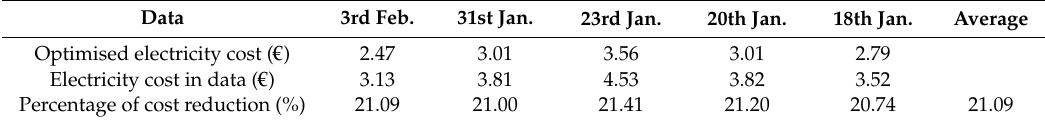
Table 1. Summary of results of the standard PSO for five cold winter days in